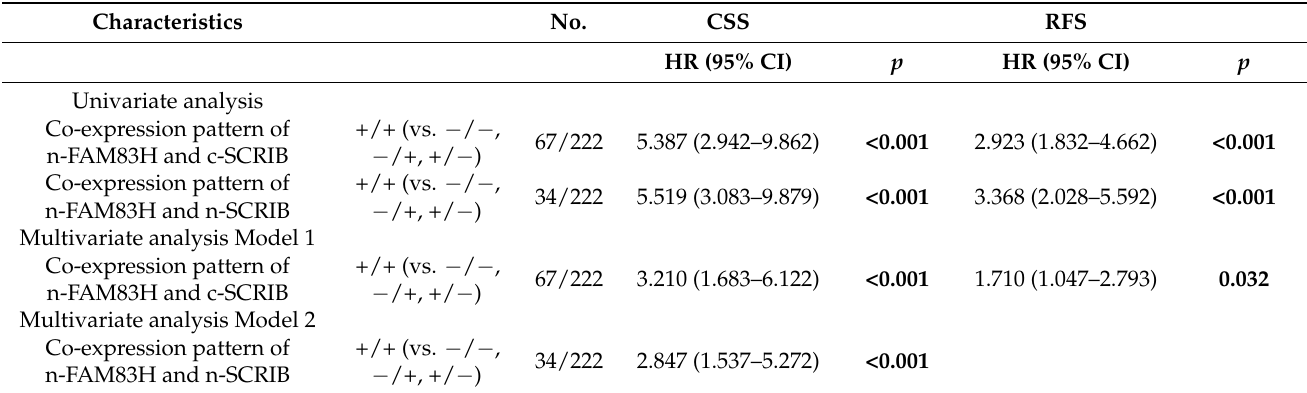
Table 5. Univariate and multivariate Cox regression analysis for cancer-specific survival and relapse- free survival according to the co-expression patterns of FAM83H and SCRIB in